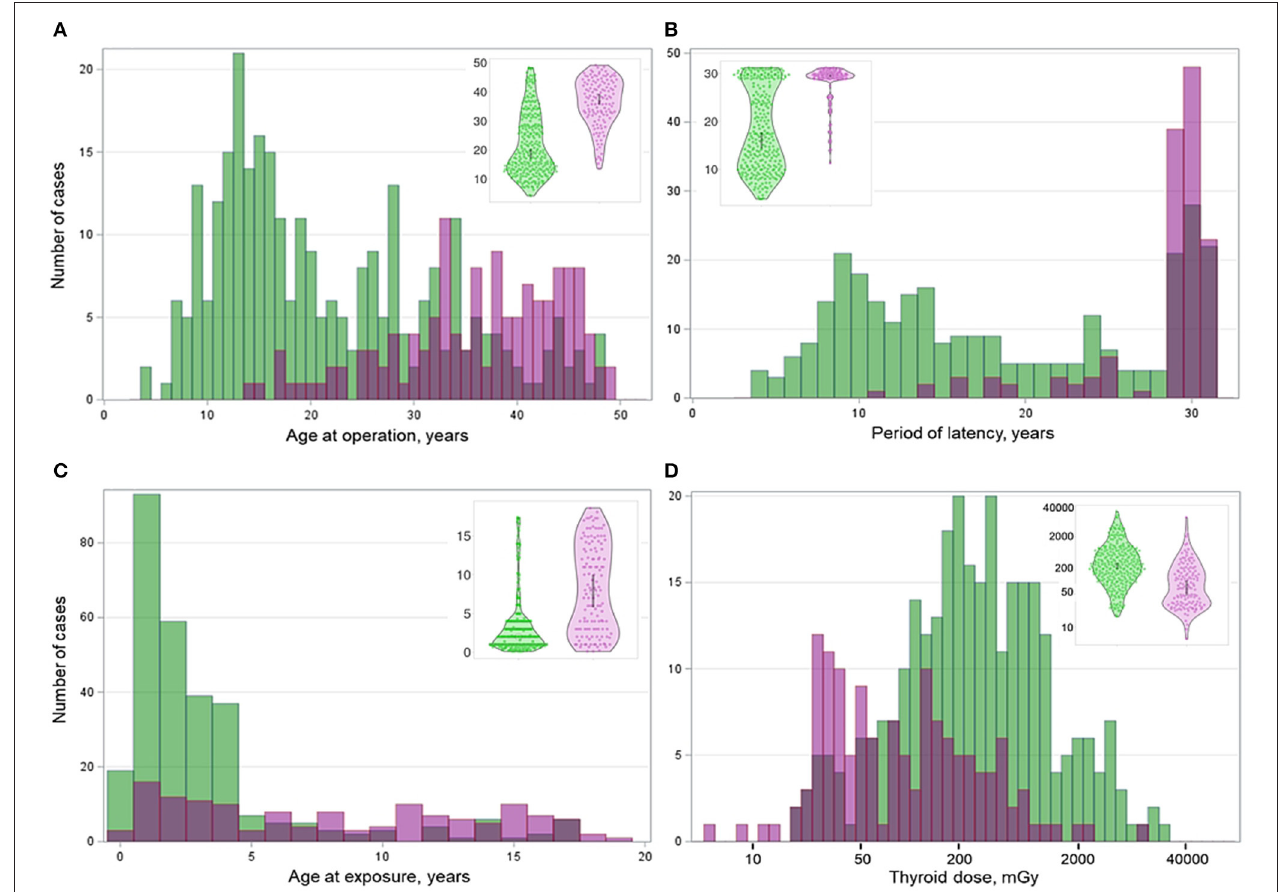
FIGURE 2 | Distribution of the BRAF V600E -positive (purple color) and BRAF V600E -negative (green color) radiogenic PTCs by (A) age at operation, (B) age at exposure, (C) period of latency, and (D) thyroid dose. Insets are violin plots of corresponding distributions; the gray boxes inside indicate the 95% confidence